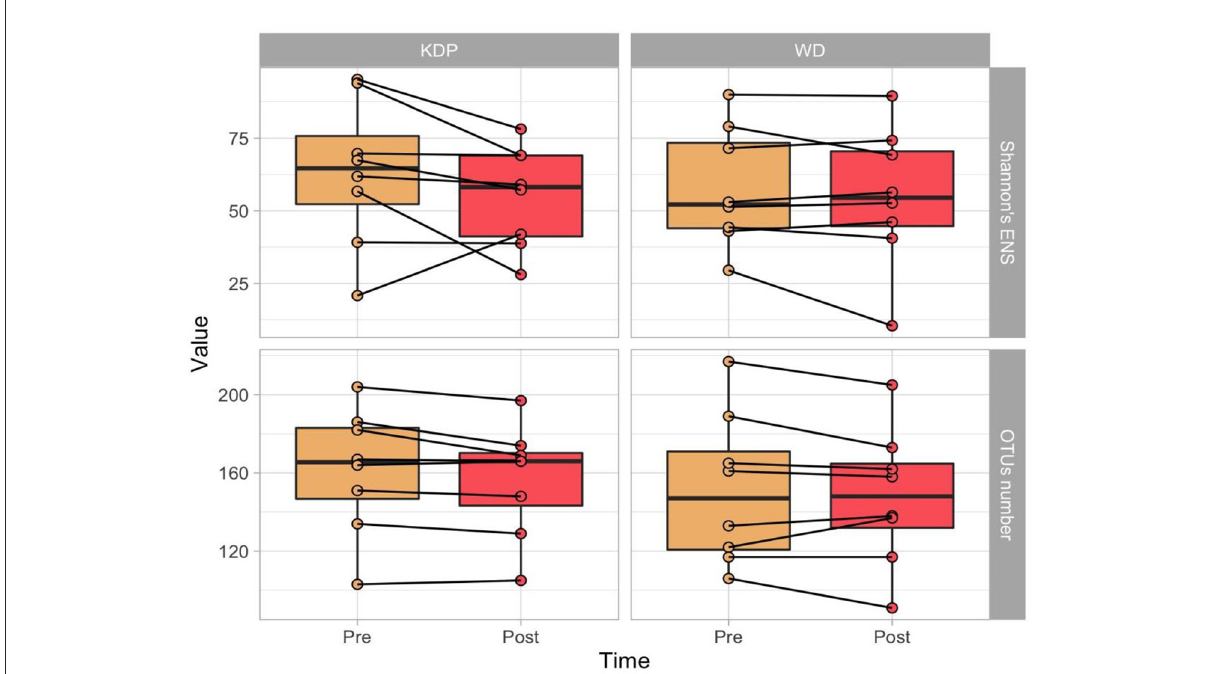
FIGURE2 Paired boxplots of OTU’s number and Shannon’s Effective Number of Species (ENS) in the two groups (KDP vs. WD), at the two time points (Pre and Post Intervention).